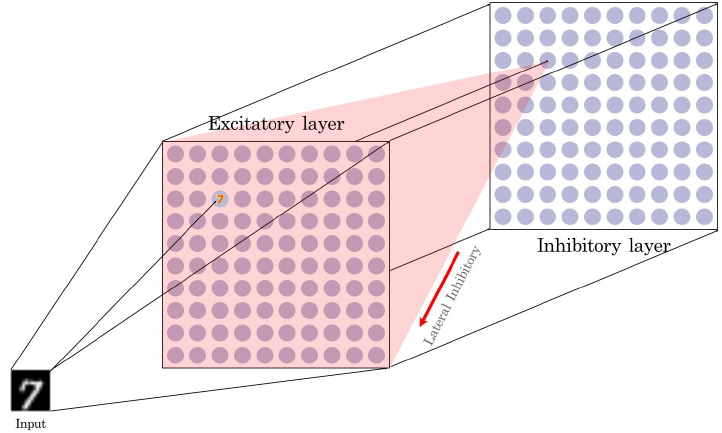
Figure 2. The SNN architecture of this paper consists of an input layer, an excitatory layer, and an inhibitory layer, and contains 784, 100, and 100 neurons,